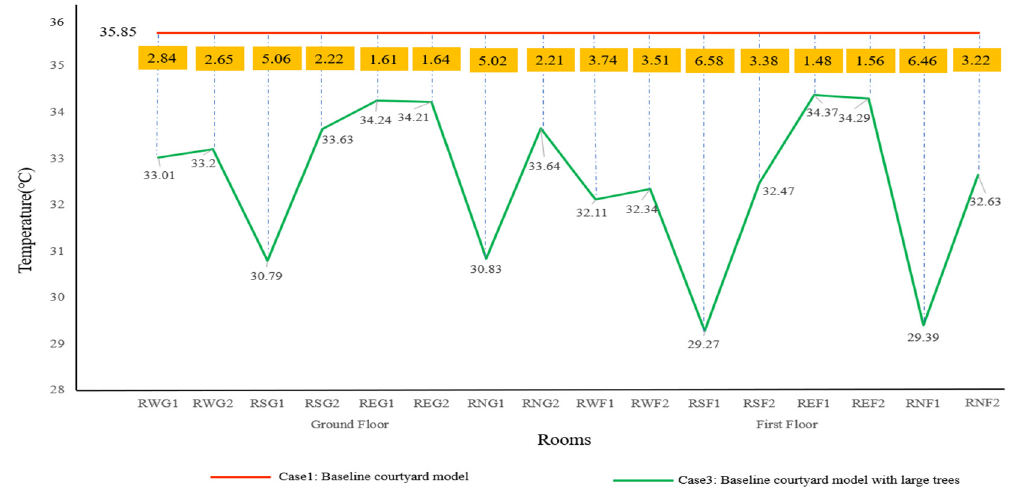
Figure 25. Comparison of air temperature for Case 1 and Case 3 in each room.